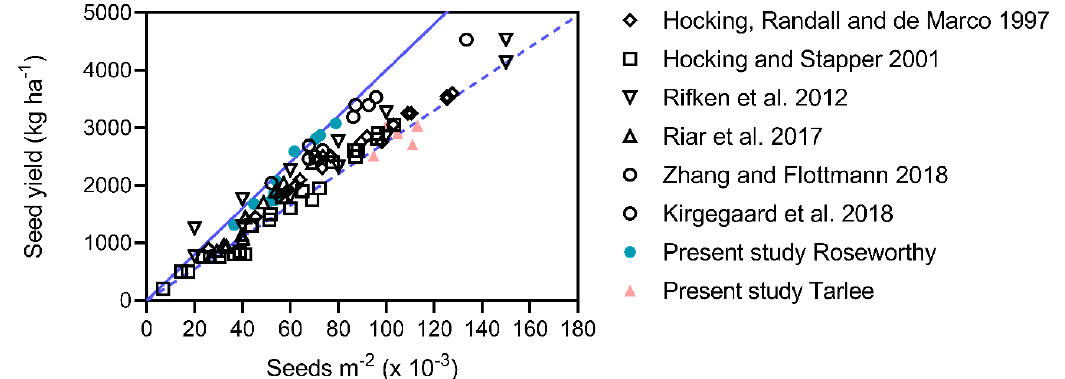
Figure 2. Relationship between seed yield and seed number for canola at Tarlee, Roseworthy irrigated and rainfed treatments in comparison to other studies from southern and western Australia. Dotted line represents lower boundary function (equivalent to 2.75 mg seed weight) and solid line represents upper boundary function (4.0 mg seed weight) for the relationship [13,25,27,29,44,45].